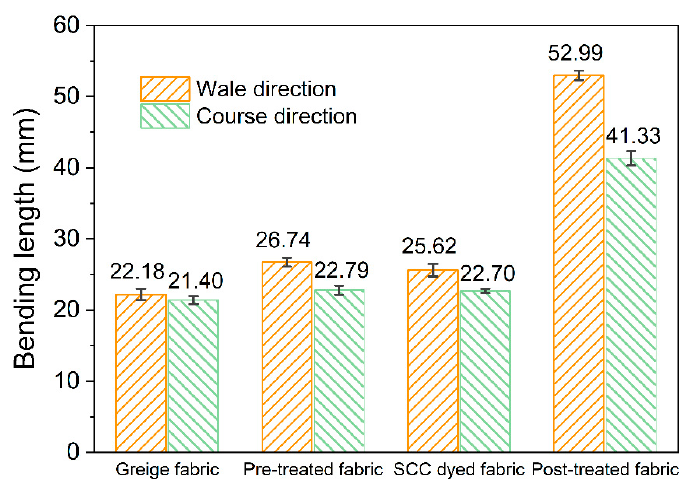
Figure 8. Handle of the samples.